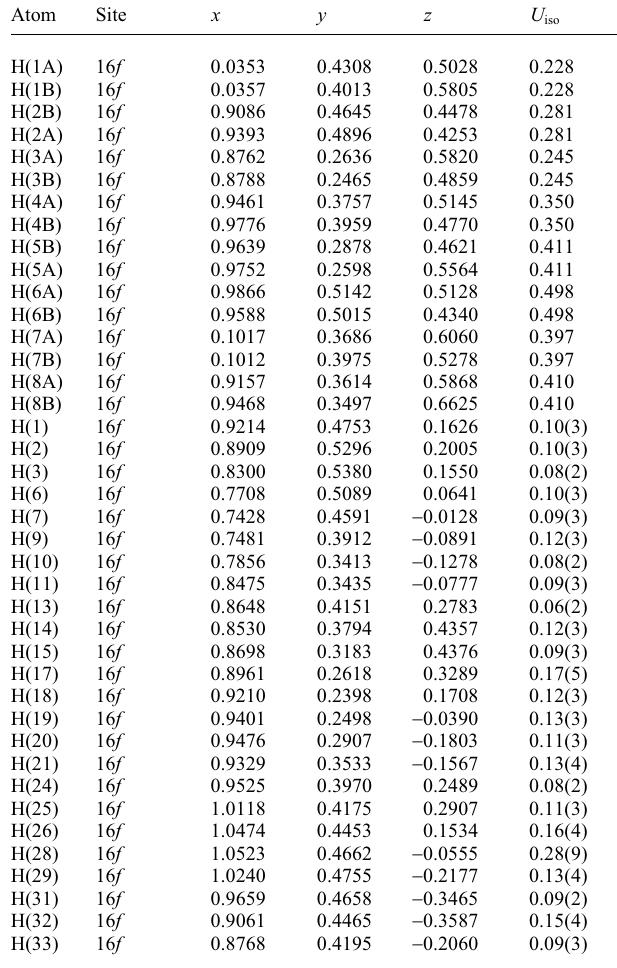
Table 2. Atomic coordinates and displacement parameters (in Å 2 )